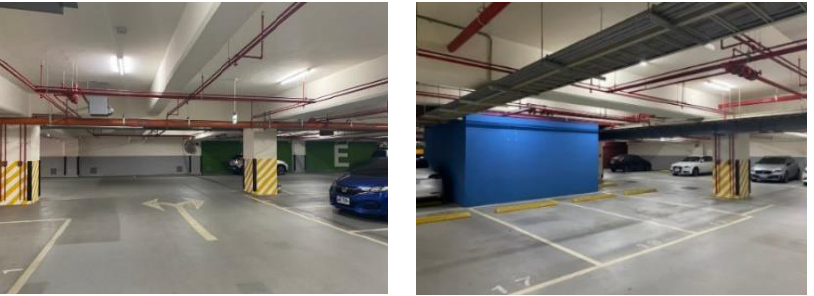
Figure 4. Calibration site.